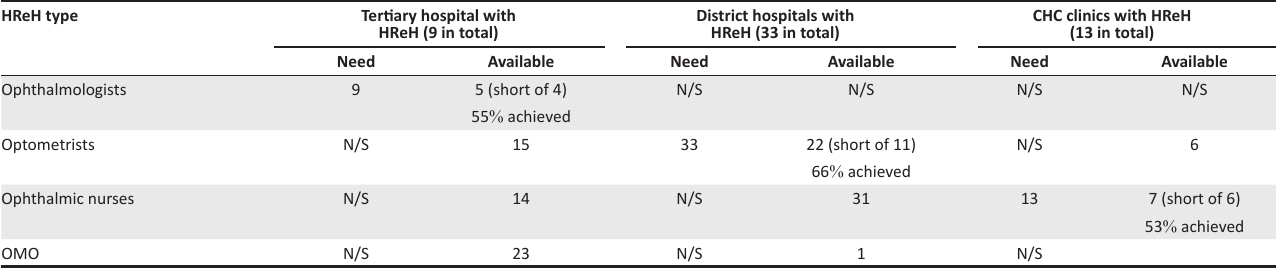
TABLE 2: Human resources for eye health needs analysis according to the National Prevention of Blindness RSA which categorises staffing according to healthcare facility (HCF) types/levels where surgeons are specified to practise mainly in level 3 (mainly ophthalmologists) and level 2 (mainly ophthalmic medical officer ) HCFs, optometrists in district hospitals and ophthalmic nurses in community health centre.